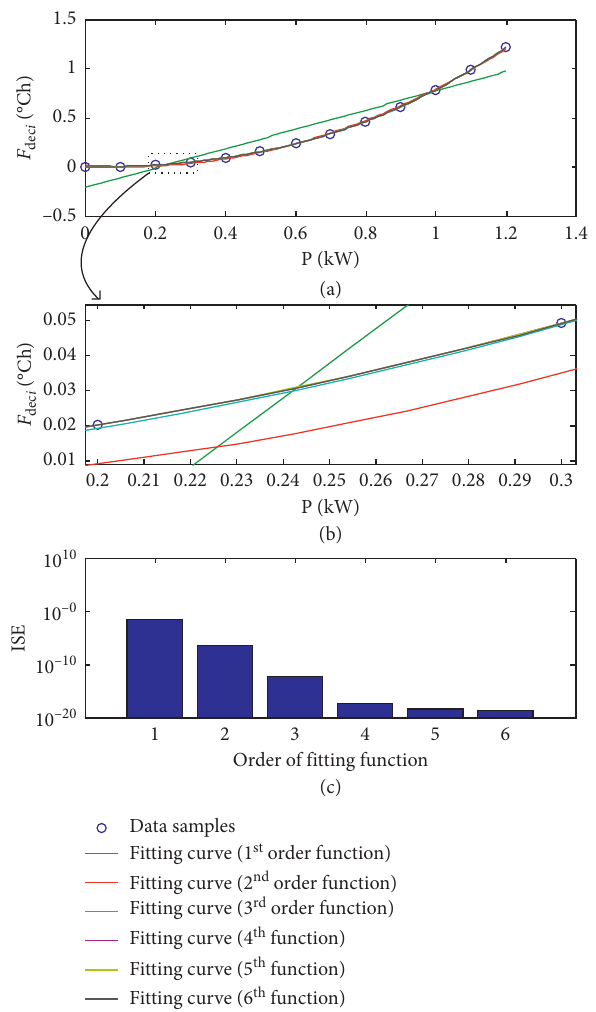
Figure 5: Fitting results of the cost F dec with different orders. (a) Adjustment cost fitting curve with different orders of fitting function. (b) Adjustment cost fitting curve with different orders of fitting function (zoomed in). (c) ISE with different orders of fitting function.